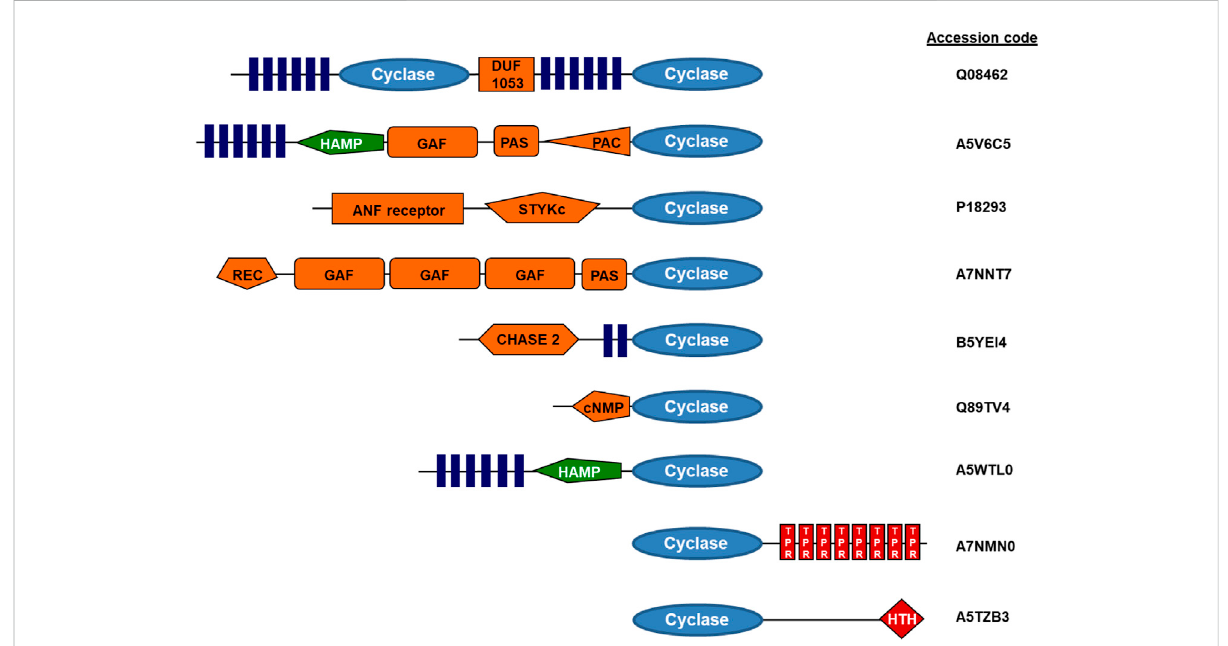
FIGURE 1 Examples of modular adenylyl cyclase proteins (domain symbols adapted from EMBL-SMART). Q08462, human adenylyl cyclase, type 2; A5V6C5, adenylyl cyclase from Sphingomonas wittichii; A7NNT7, Rosei fl exus castenholzi adenylyl cyclase with GAF and PAS/PAC sensors; B5YEI4, Dictyoglomus thermophilum adenylyl cyclase; Q89TV4, Bradyrhizobium japonicum adenylyl cyclase; A5WTL0, mycobacterial adenylyl cyclase Rv3645; A7NMN0, Rosei fl exus castenholzii adenylyl cyclase with terminal TPR repeats; A5TZB3, mycobacterial adenylyl cyclase Rv0386 with a helix-turn-helix terminal transcriptional regulator ( fi gure adapted from ref. Schultz and Natarajan,